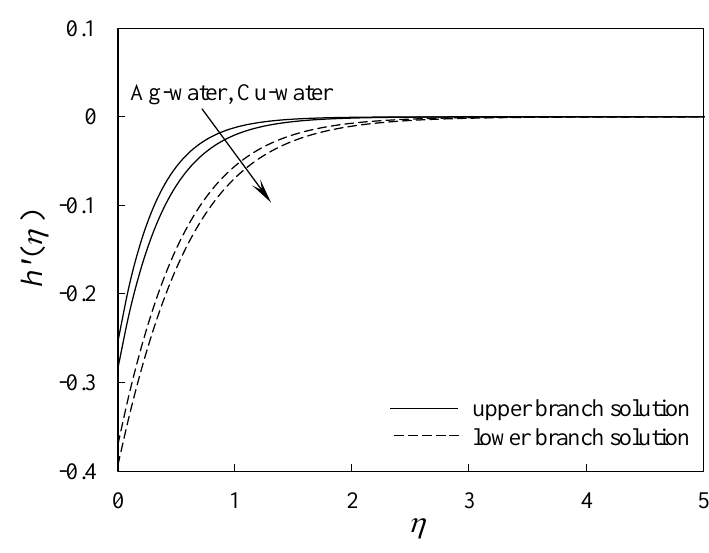
  h  when  = −1, N = 1, K = 1, and M = 1.